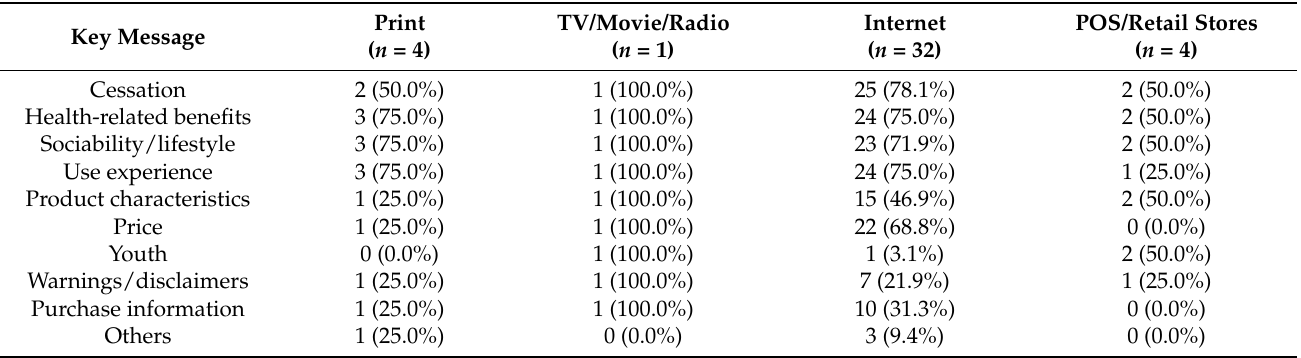
Table 2. Frequency of marketing communication messages across communication channels in published studies ( n = 40 *).